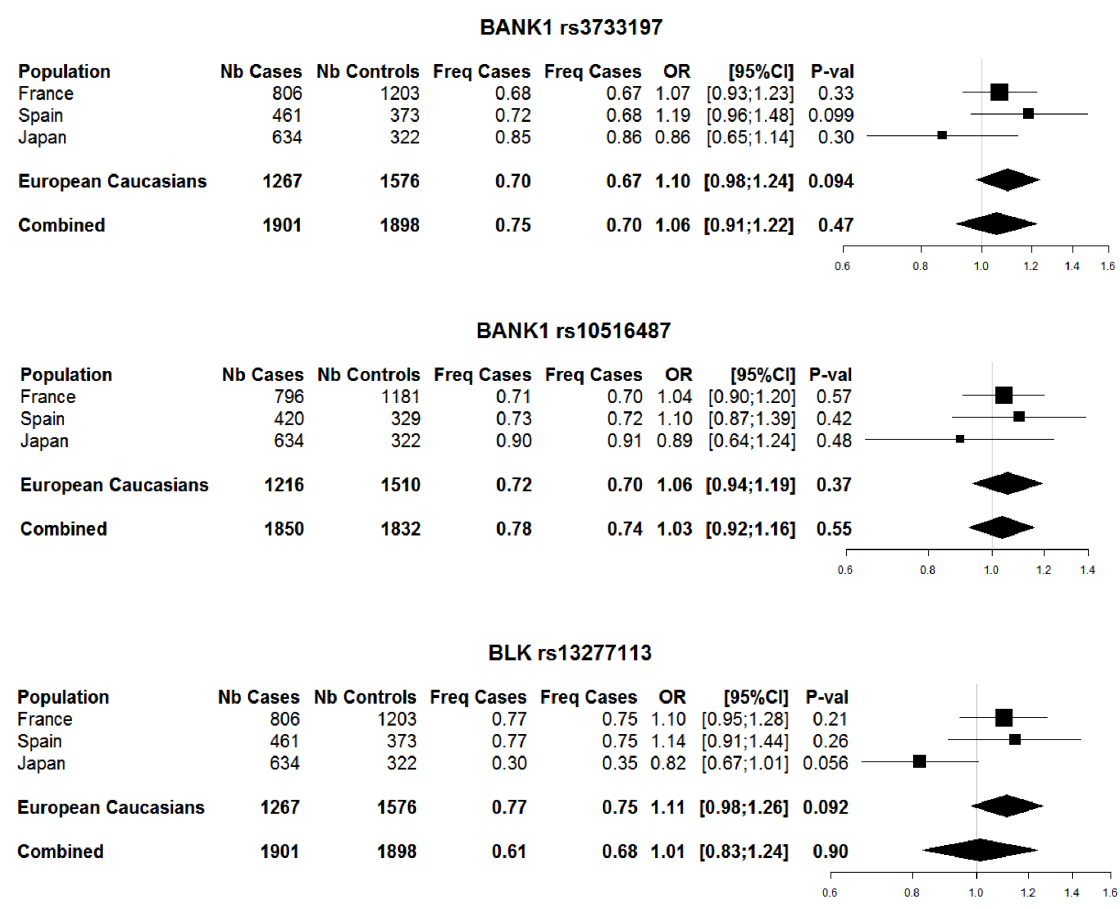
Figure 1. Results of single marker analysis in populations genotyped for both BANK1 and BLK . Number of cases and controls, frequency of G allele, odds ratio (OR) and 95% confidence interval (95% CI) and P -value of the association under a multiplicative model for each population separately, for European Caucasians and for the combined dataset (France, Spain and Japan). doi:10.1371/journal.pone.0061044.g001 PLOS ONE |